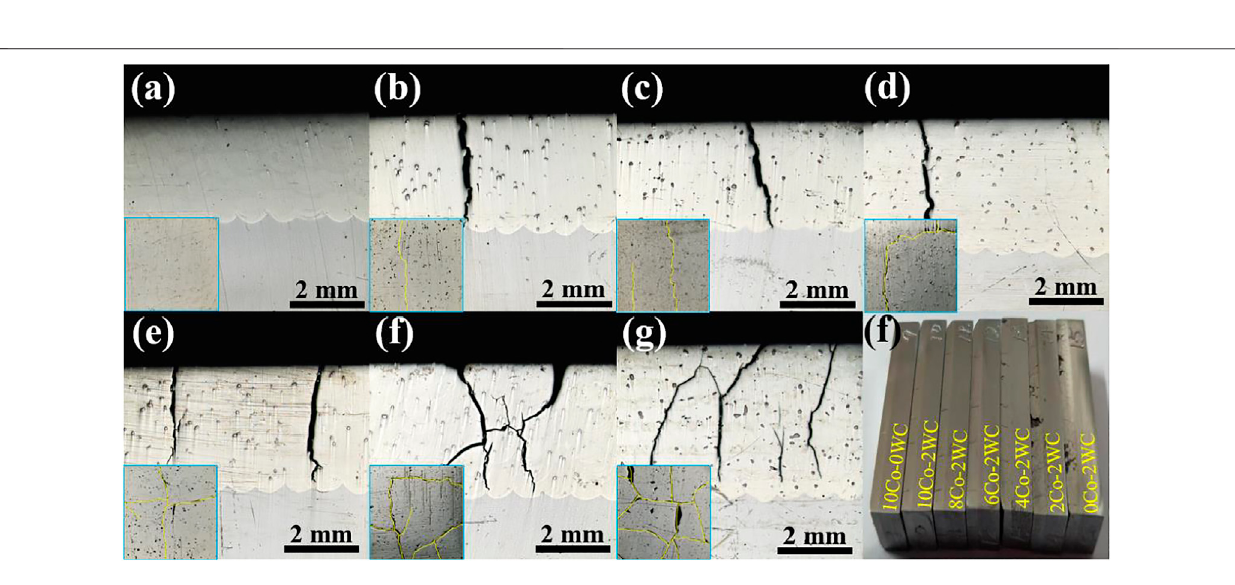
Frontiers in Materials |